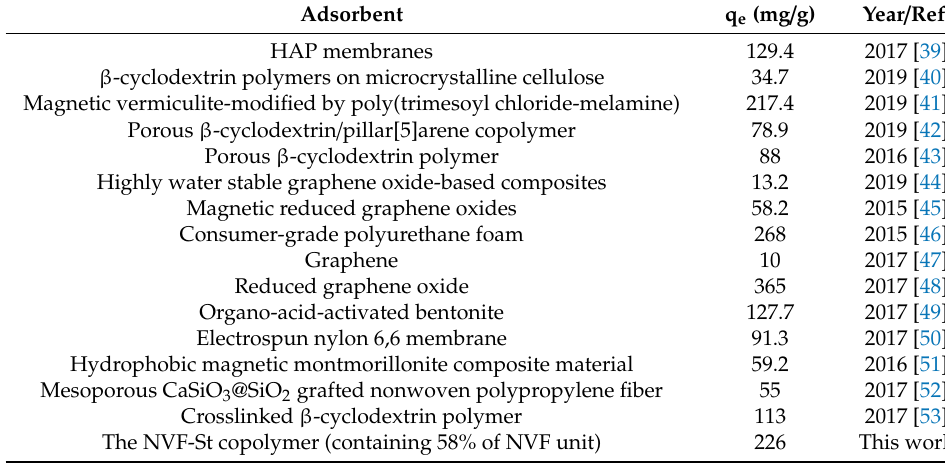
The NVF-St copolymer (containing 58% of NVF